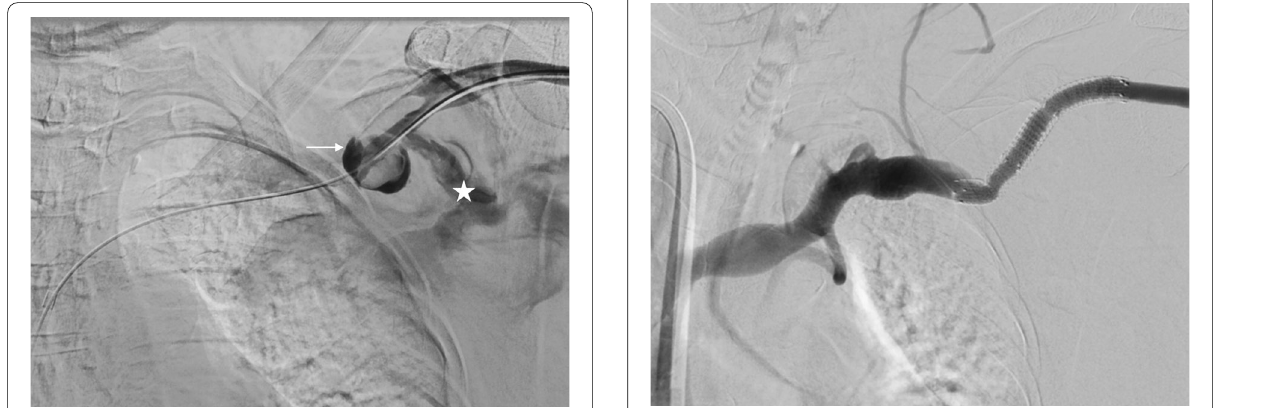
Fig. 1 Fistulogram shows contrast extravasation in the chest wall (star) associated with thrombosis of the cephalic vein proximally as well as partially thrombosed aneurysm centrally (white